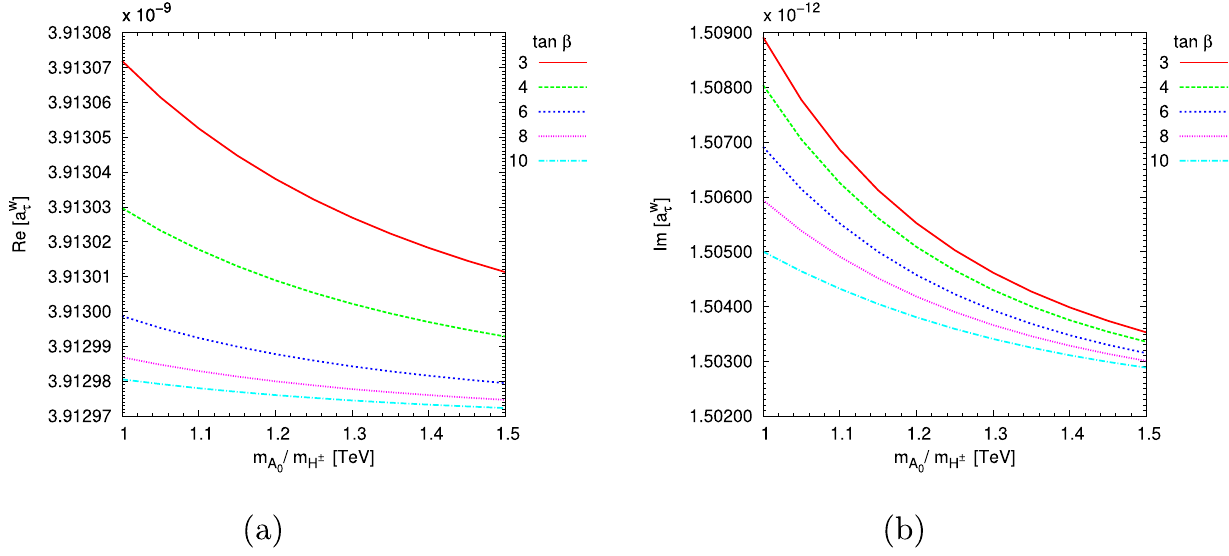
Fig. 12 Total contribution to a W τ for different values of tan β . a Re( a W τ ). b Im( a W τ ). The plots are obtained for fixed values of the f = 1000 GeV and F = 4000 GeV. The values provided in Table 3 are used for the remaining parameters of the model